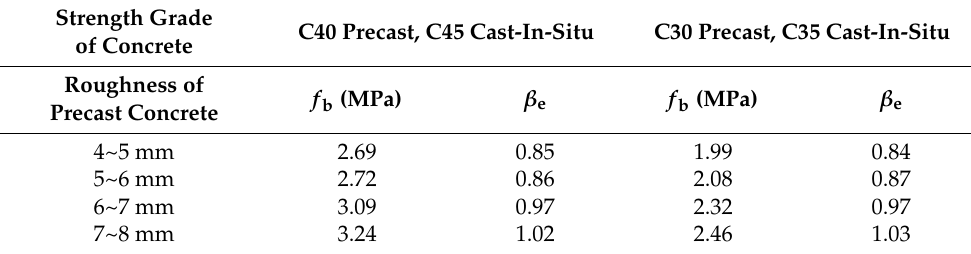
Table 10. Bond strength of interface with different roughness of precast concrete.